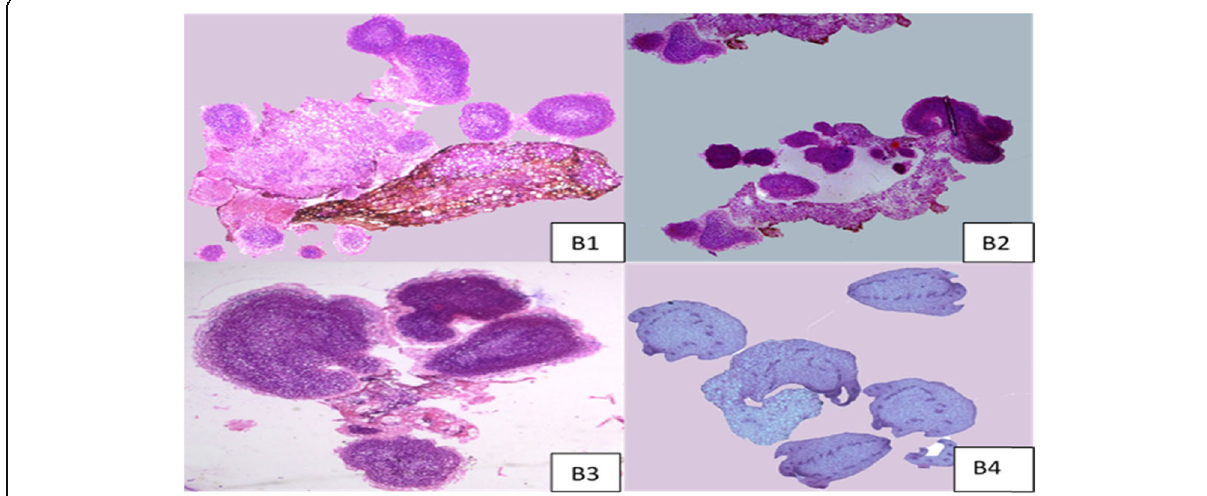
Fig. 2 Histological observation of different stages of somatic embryos. B1 Globular-shaped embryo. B2 Heart-shaped embryo. B3 Torpedo- shaped embryo. B4 Primary